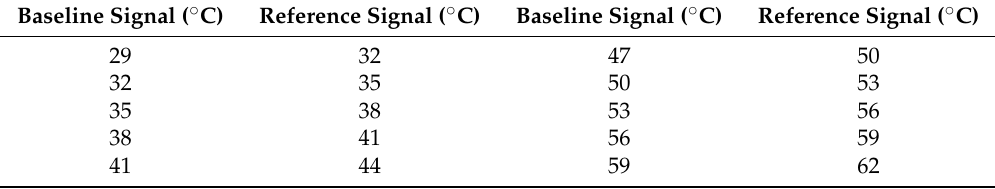
Table 1. The baseline signals and reference signals used for determining the temperature interval.